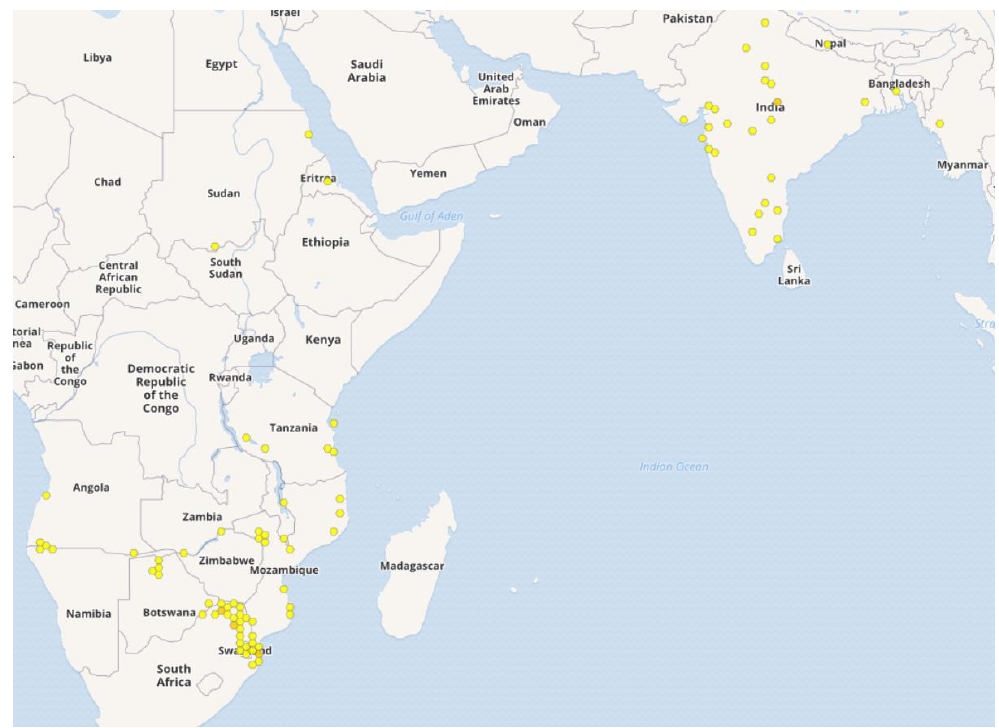
Figure 2. Distribution of C. hirsutus in Asia and Africa. (Source: GBIF, https: // www.gbif.org / species / 7930800